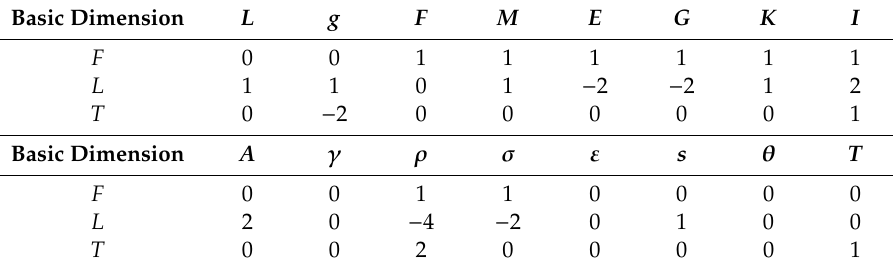
Table 2. Basic dimensions of related